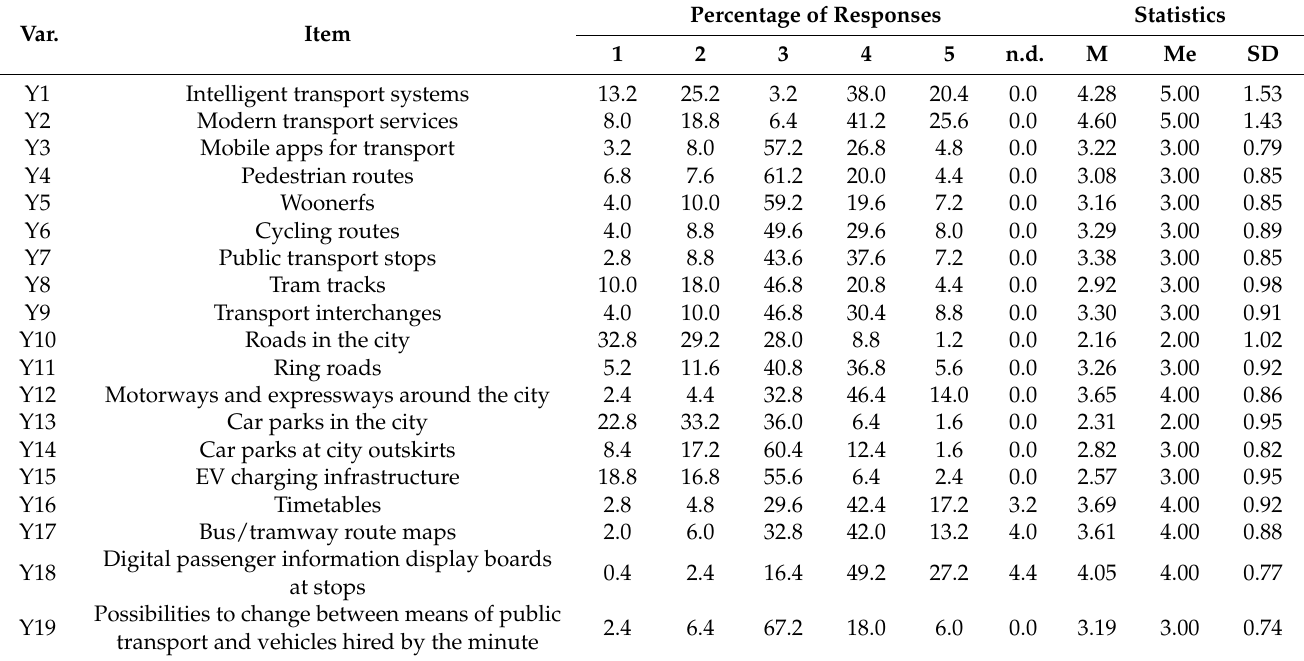
Table 6. Assessment of the development of sustainable and intelligent transport system in